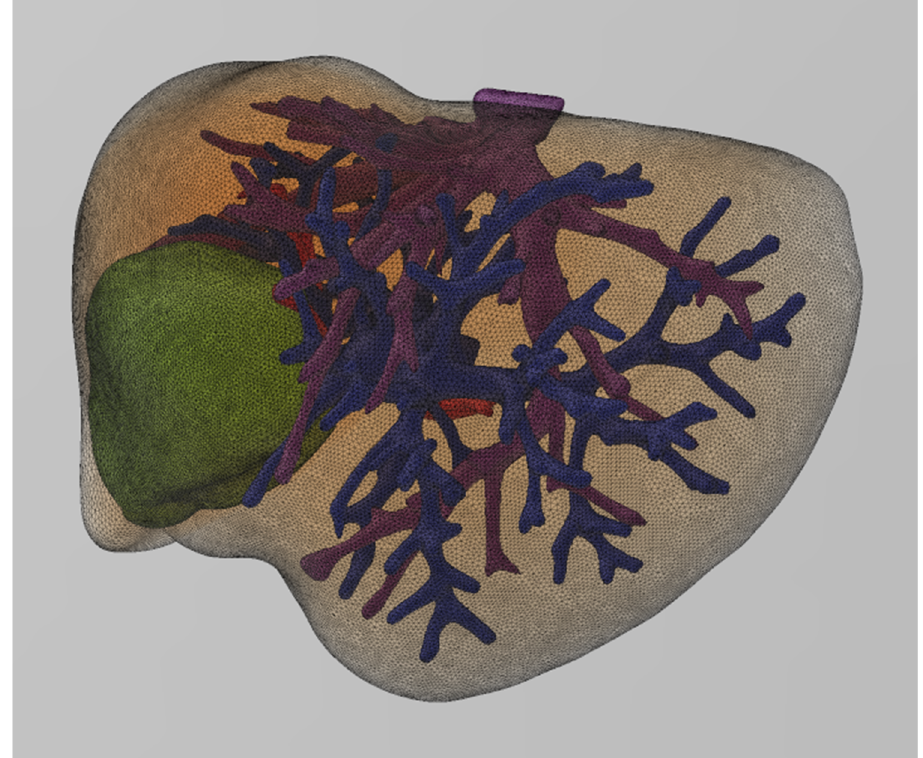
Figure 6. Patient’s liver anatomy. The complete model of the patient’s liver is presented. Parenchyma is presented in beige transparent color, hepatic vein in purple, aorta in red, portal vein in blue, and tumor in green.